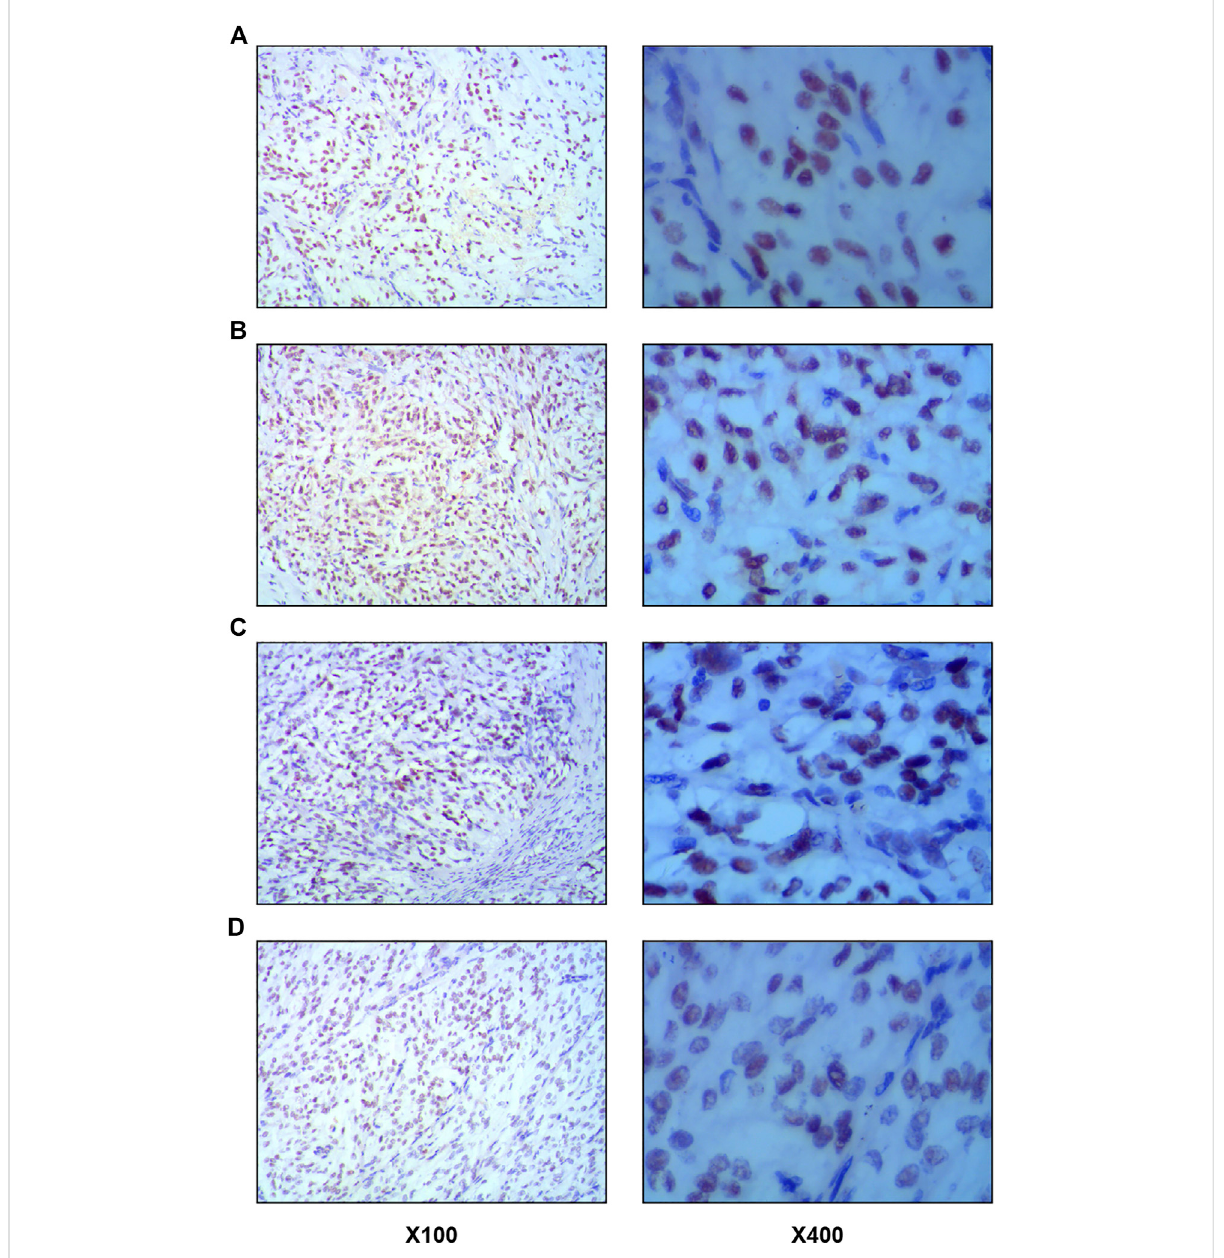
FIGURE 8 Representative images of positive immunohistochemical staining of MLH1, MSH2, MSH6 and PMS2. Left images × 100; right images × 400. (A) . MLH1 protein expression. (B) . MSH2 protein expression. (C) . MLH6 protein expression. (D) . PMS2 protein